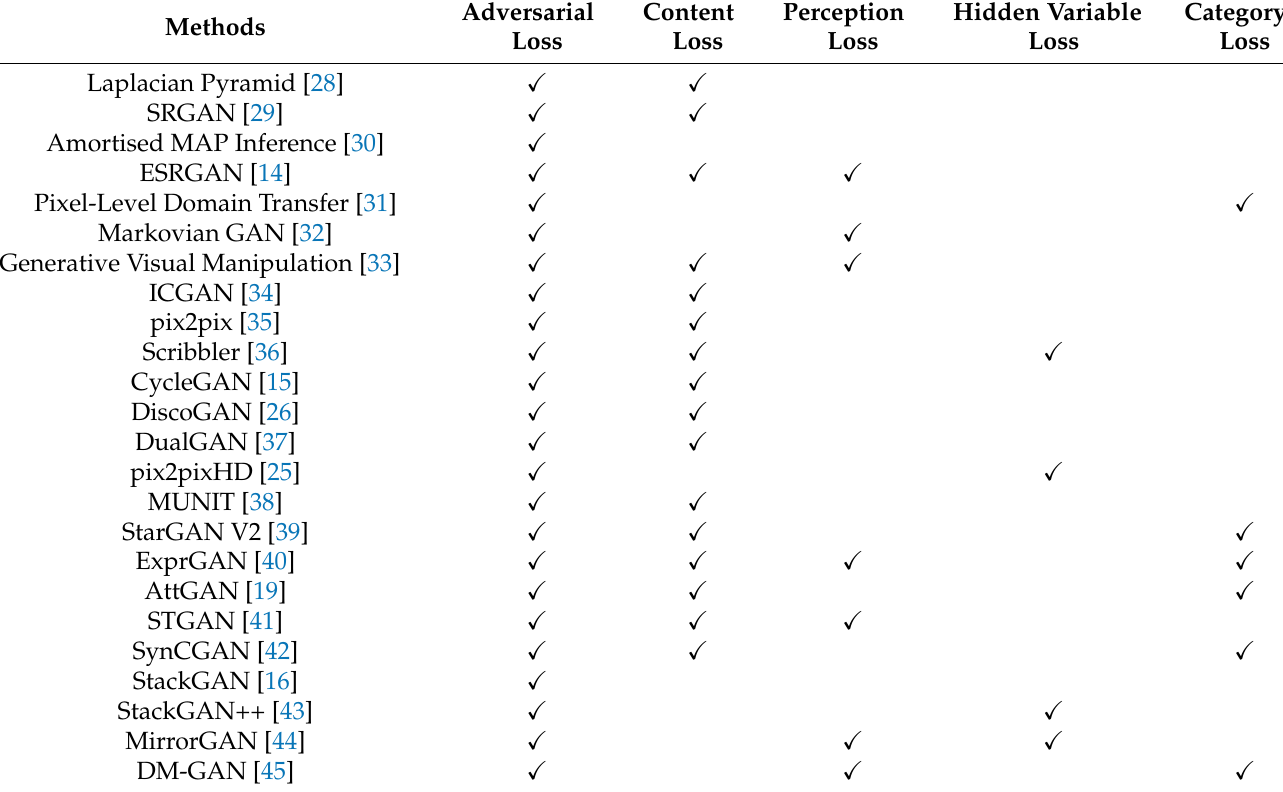
Table 2. The usage of loss functions in various